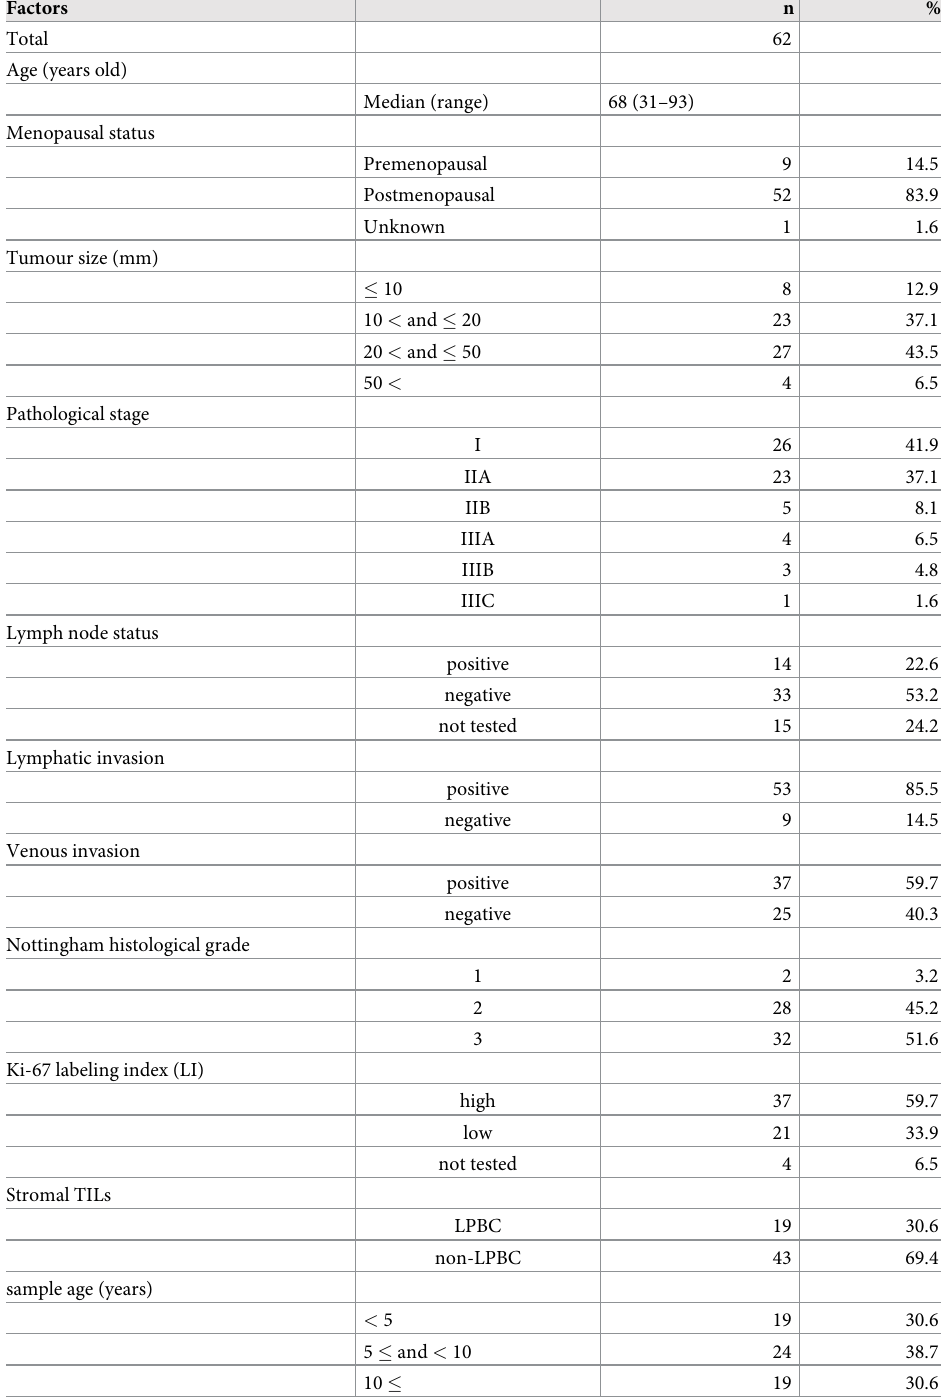
Table 1. Clinical characteristics of patients with triple-negative breast